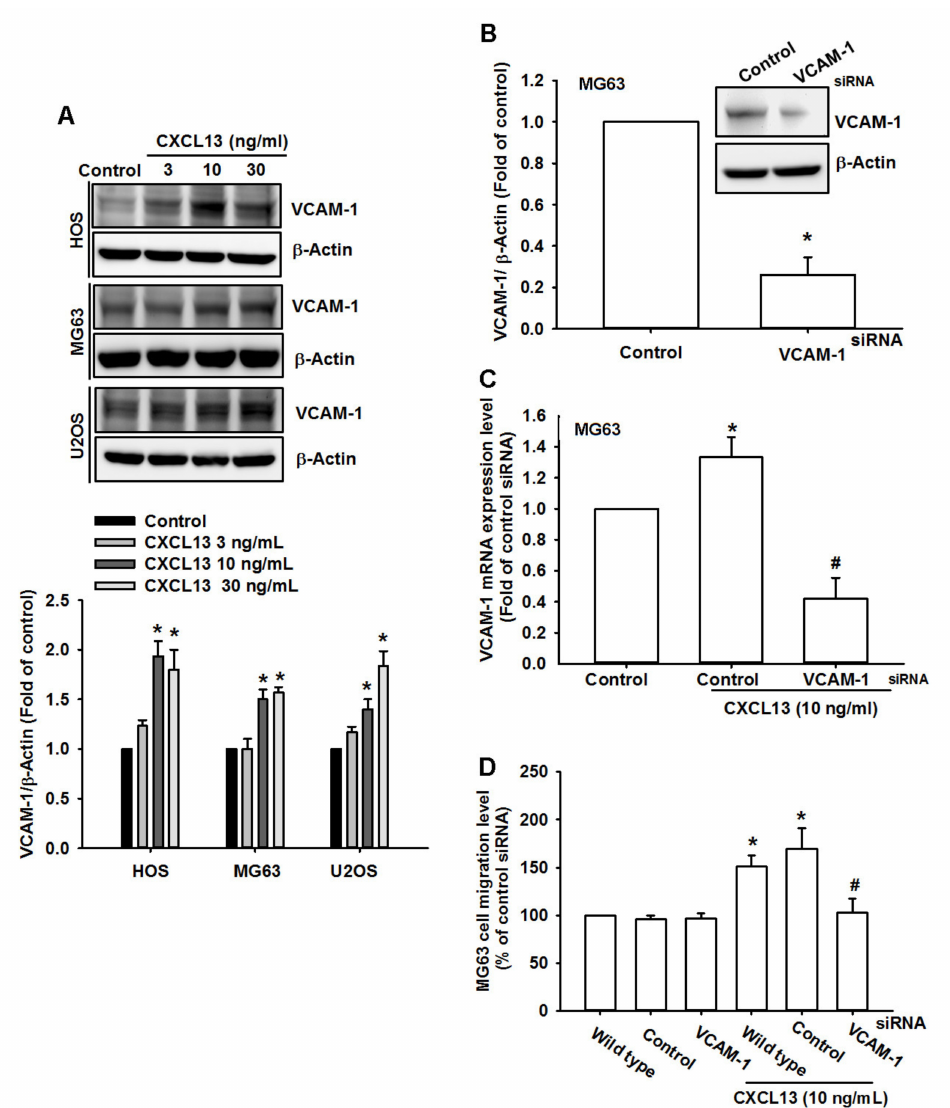
Figure 2. CXCL13 promotes osteosarcoma migration by increasing vascular cell adhesion molecule 1 (VCAM-1) expression. ( A ) Cells were incubated with CXCL13 (3–30 ng / mL) and VCAM-1 expression was examined by Western blot. ( B – D ) MG-63 cells were transfected with VCAM-1 siRNA then stimulated with CXCL13; VCAM-1 expression and migratory potential was examined by Western blot, qPCR, and Transwell assays. * p < 0.05 compared with the control group; # p < 0.05 compared with the CXCL13-treated